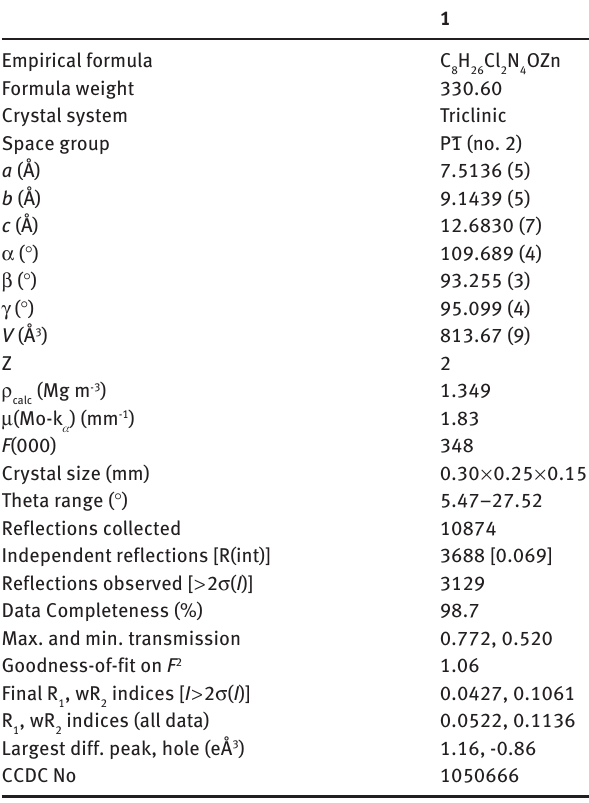
Table 2: Crystal data for compound 1